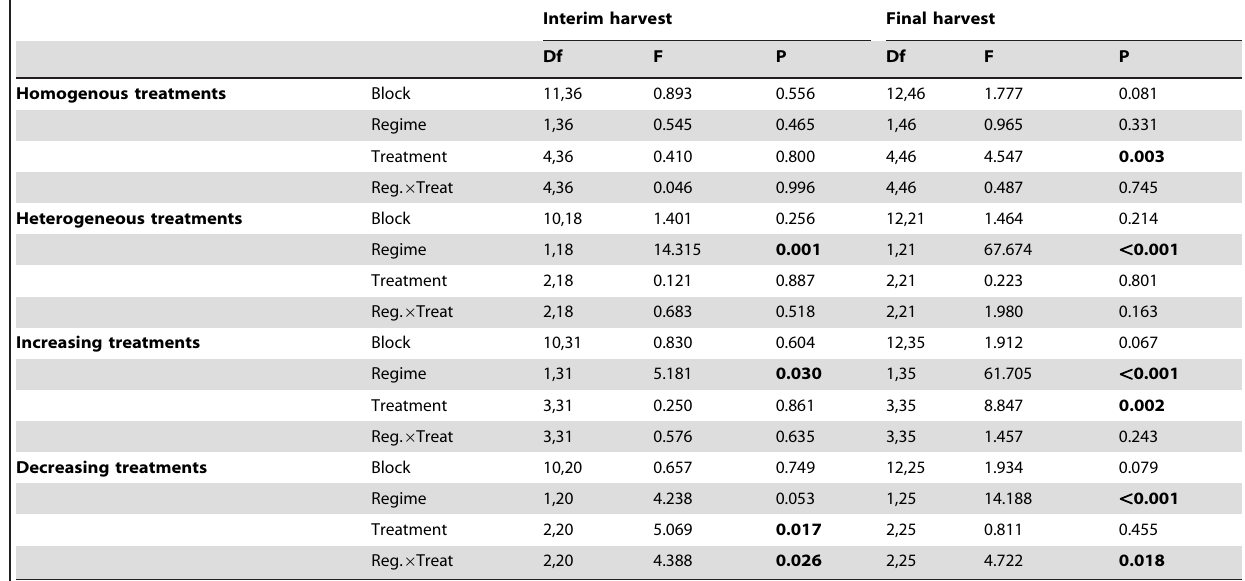
Interim harvest Final